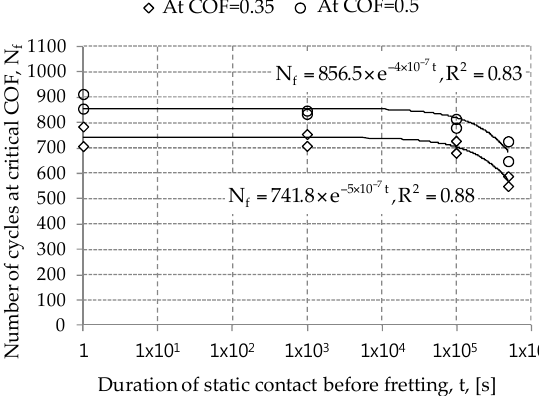
Figure 9. Number of cycles to the critical friction coefficient (COF) versus the logarithm of the duration of static contact before fretting. Smooth lines are fitted curves. The COF of 0.35 presents the beginning of sudden increase after a steady state sliding, while the value of 0.5 indicates the final of the test.